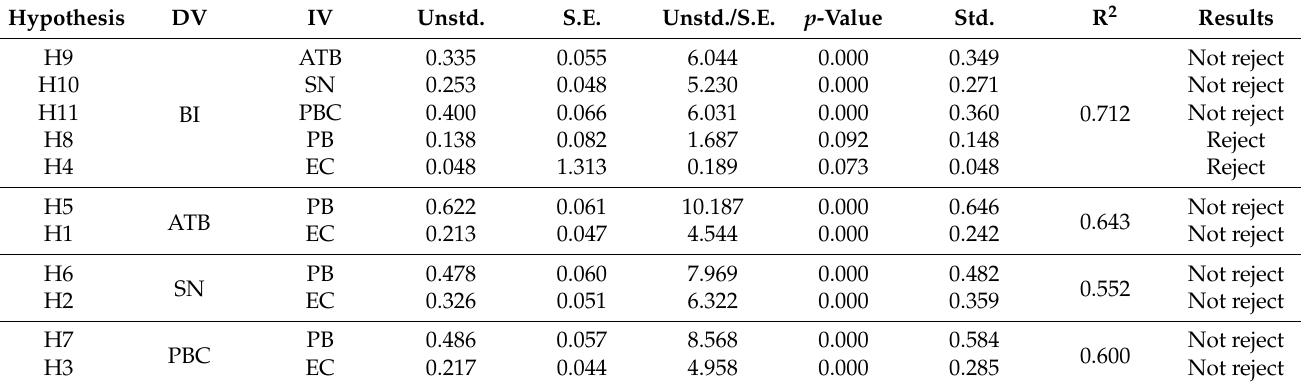
Table 6. Regression